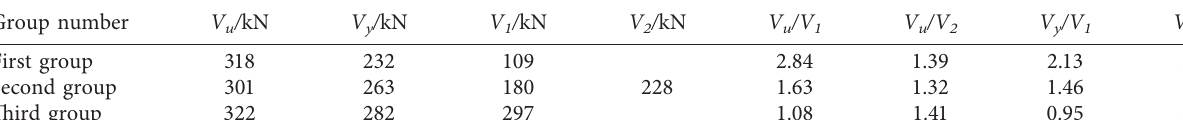
Table 5: Shear bearing capacity and its ratio.